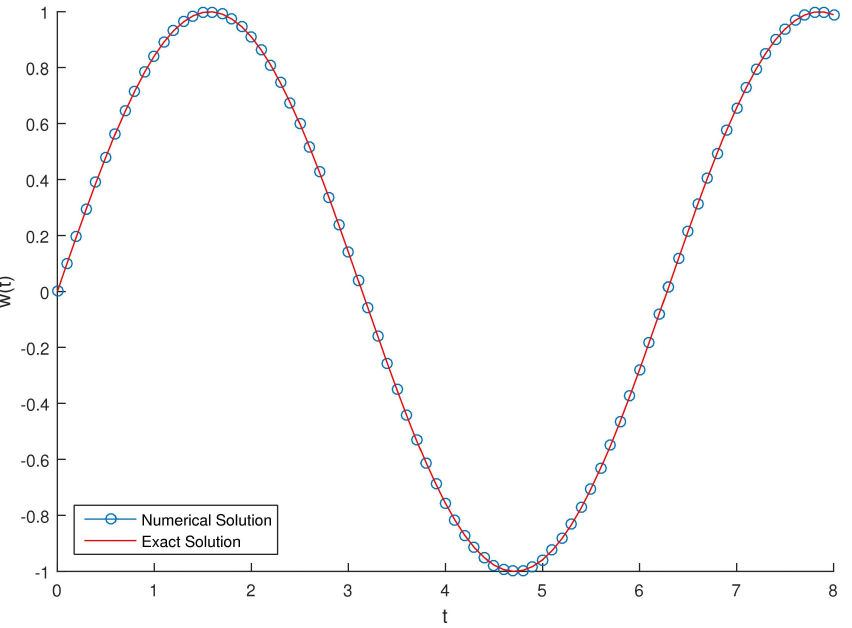
Figure 20. The demonstration of the approximate and exact solutions for Example 6 in the interval t ∈ [ 0,8 ]